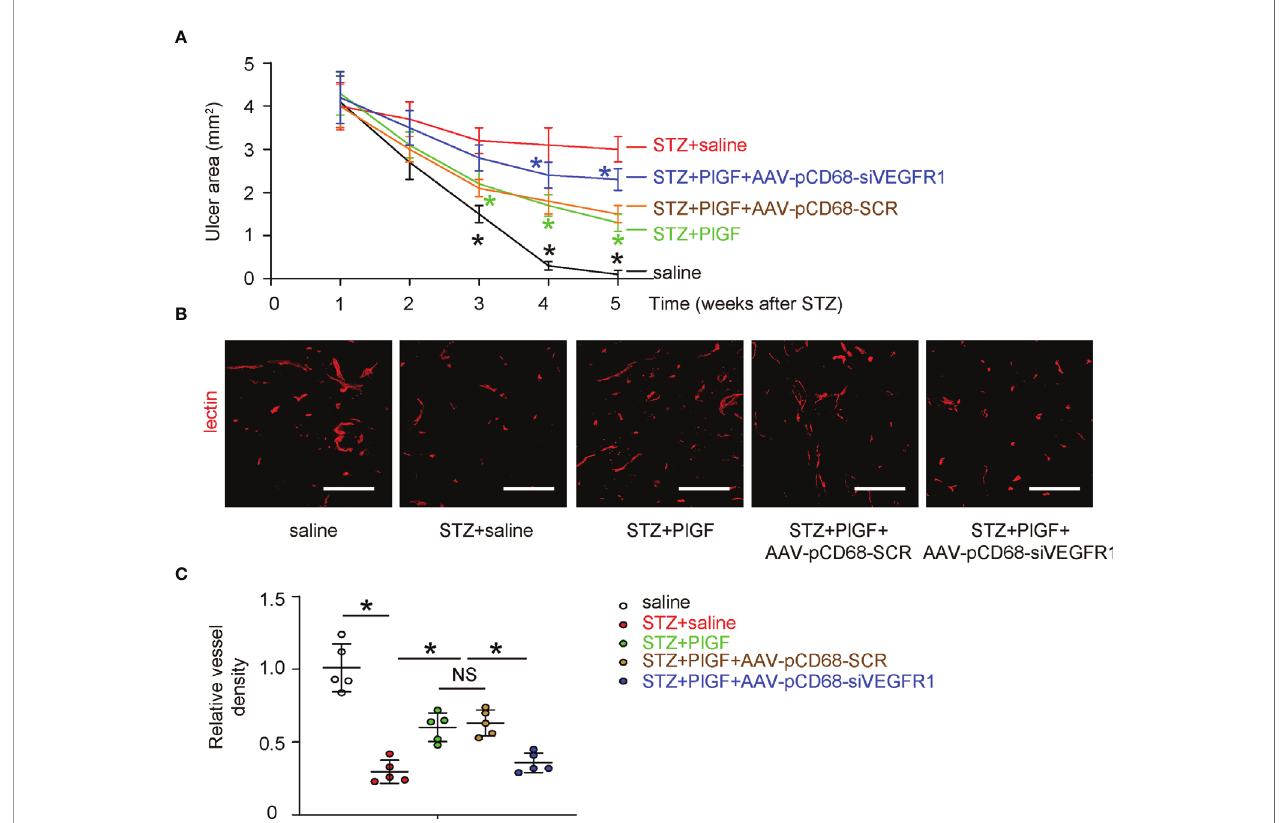
FIGURE 5 | PlGF promotes wound healing and angiogenesis, which are attenuated by macrophage-depletion of VEGFR1. (A) The effects of PlGF through macrophages on wound healing of DFD were examined. (B, C) Angiogenesis was analyzed at the end of the experiment by vessel density (5 weeks after STZ or 4 weeks after PlGF/ AAVs), shown by representative fl uorescent images (B) and by quanti fi cation (C) . *p < 0.05. In panel (A) , black star: STZ vs saline, green star: STZ+PlGF vs STZ, blue star: STZ+PlGF+AAV-pCD68-siVEGFR1 vs STZ+PlGF+AAV-pCD68-SCR. NS, non-signi fi cant. Scale bars are 100